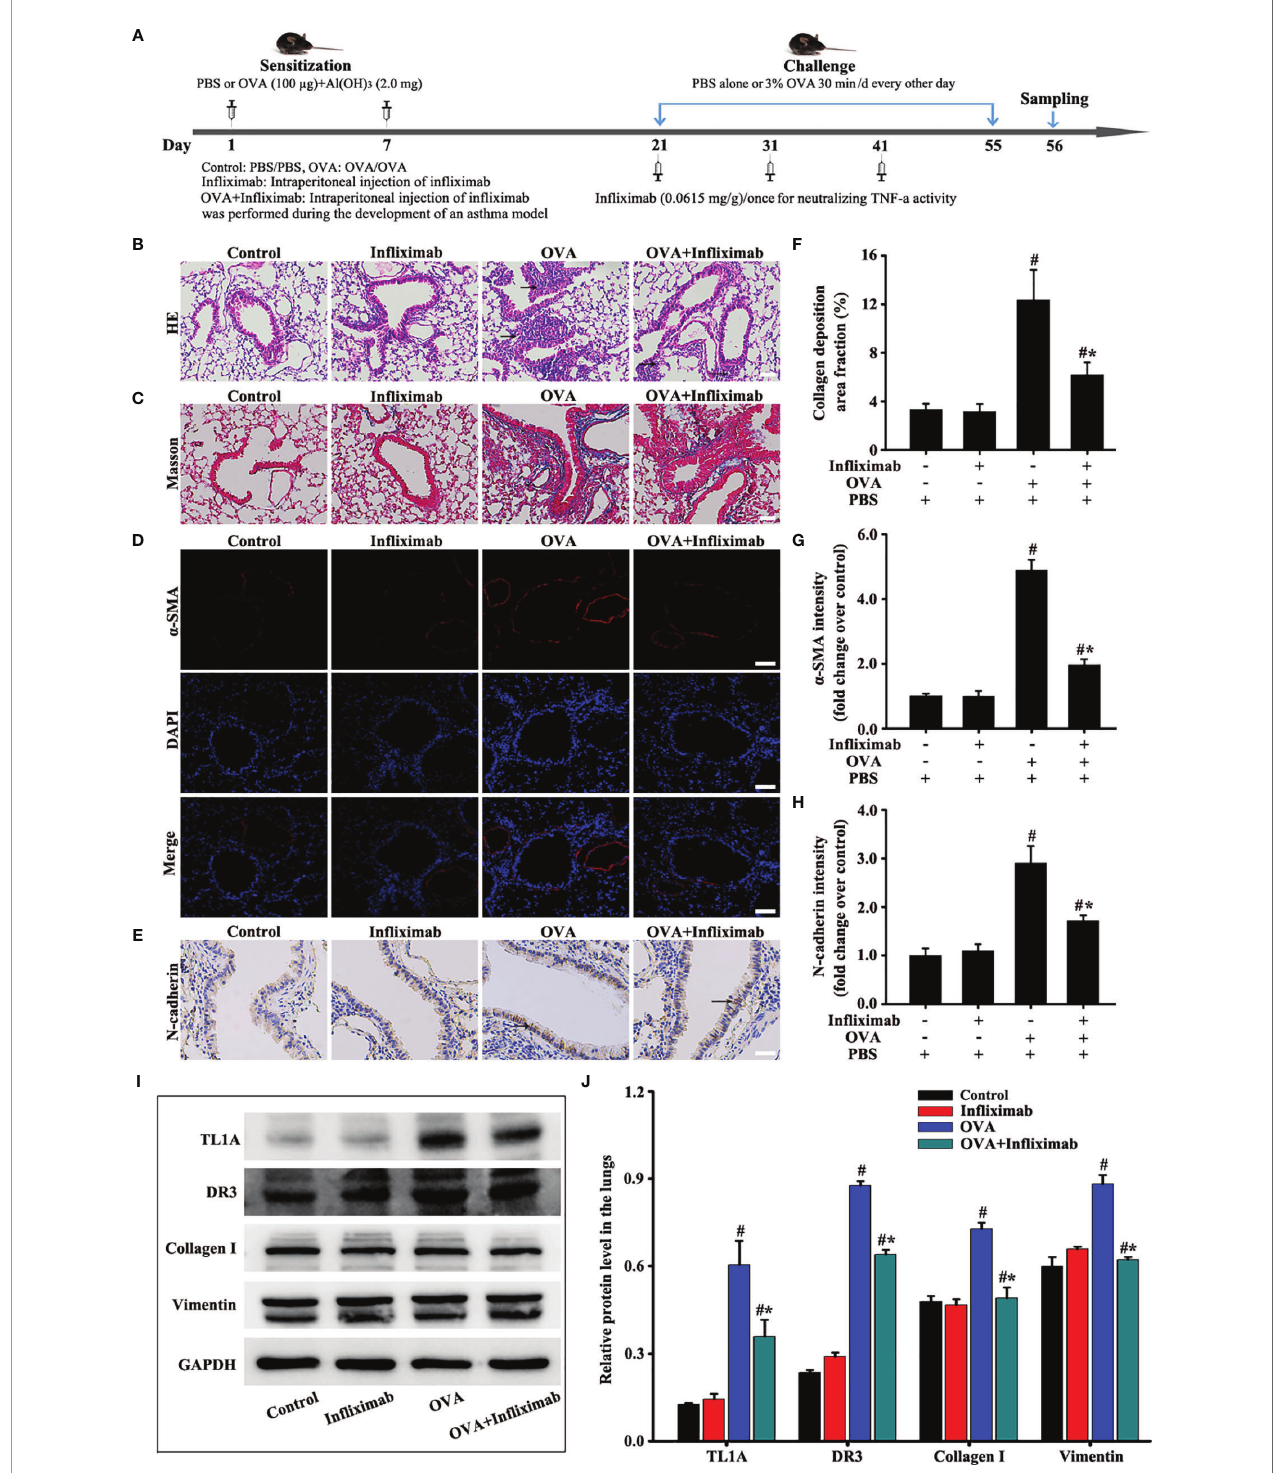
FIGURE 4 | Animal experimental schedule is shown in (A) ( n = 6 in each group). Effects of in fl iximab on OVA-induced asthma were observed. HE (B) , Masson (C) , a- SMA (D) , and N-cadherin staining (E) were detected. The effects of in fl iximab on TL1A, DR3, collagen I, and vimentin were detected by Western blotting analysis (I) . (B, C) : magni fi cation 100 ×, scale bar 100 µm. (D, E) : magni fi cation 200 ×, scale bar 50 µm. (F – H, J) intensity analysis of (C – E, I) . Data are expressed as the means ± SD for three independent experiments. # p < 0.05 versus the control group. # *p < 0.05 versus the OVA